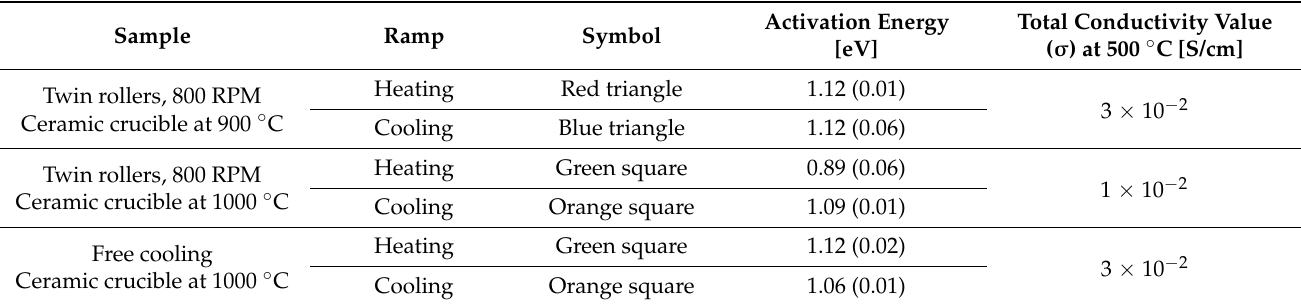
Figure 6. Arrhenius plots of samples prepared in ceramic crucibles during heating or cooling (details are given in the legend on the plot). Samples were melted in ceramic crucibles. Inset presents a representative impedance diagram at 320 ◦ C during heating for a sample prepared by free cooling method. Table 3. Activation energies for materials whose conductivity as a function of temperature is pre- sented in Figure